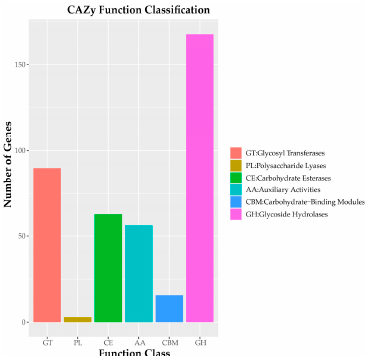
Figure 4. CAZy functional classification chart of C. pseudotenuipes .